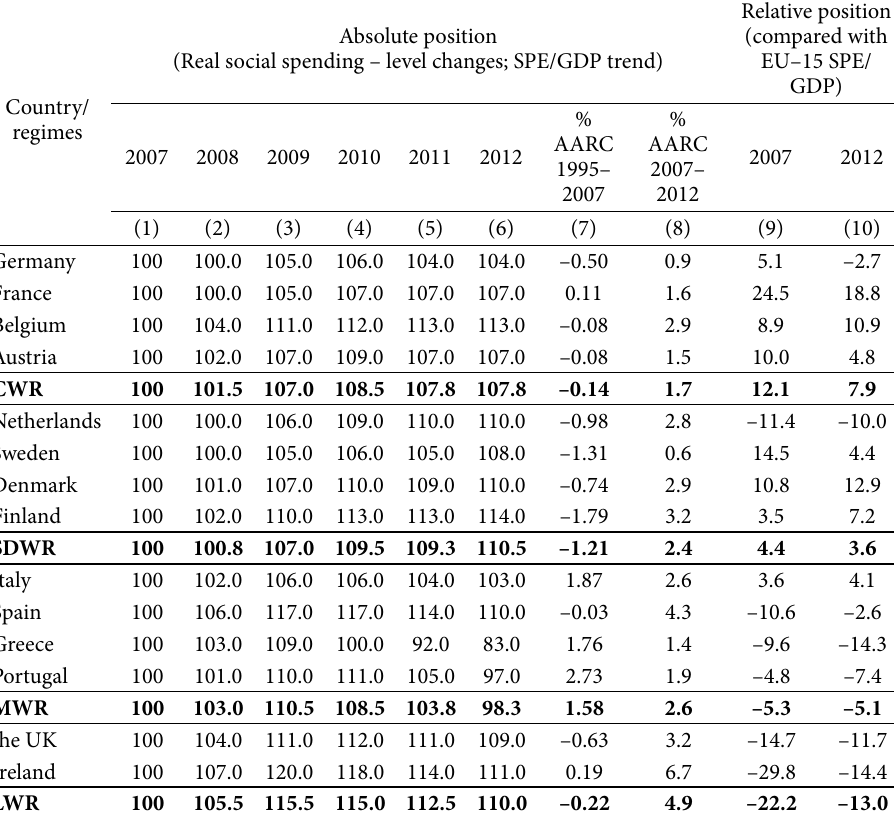
Table 3. The impact of the crisis on social public expenditure in the EU–15